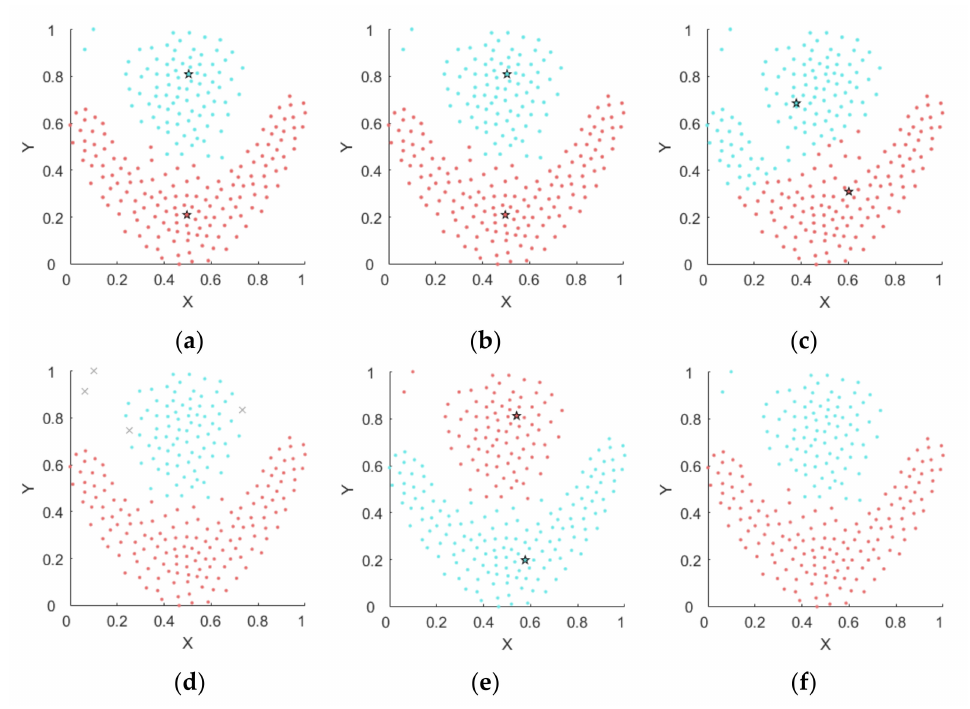
Figure 4. Results on Flame. ( a ) ConDPC, ( b ) DPC, ( c ) K-means, ( d ) DBSCAN, ( e ) DPC-DBFN, ( f ) McDPC.